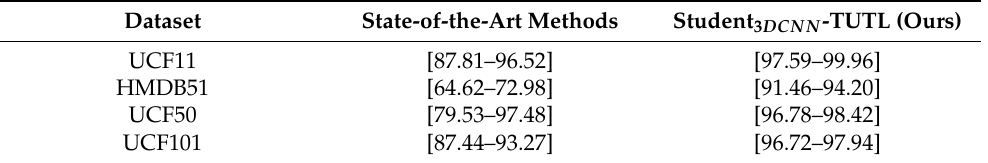
Table 11. Computed confidence interval values (with 95% confidence) for our proposed method and the state-of-the-art mainstream